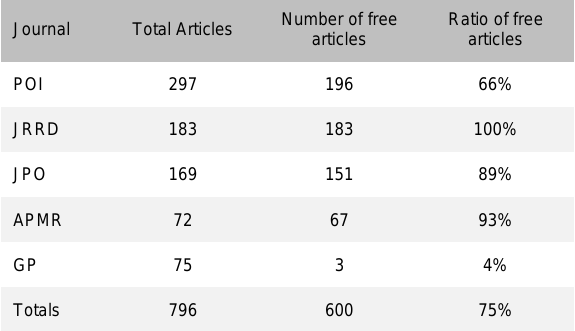
Table 2: Number of reviewed journal articles (from 2007 through 2016).